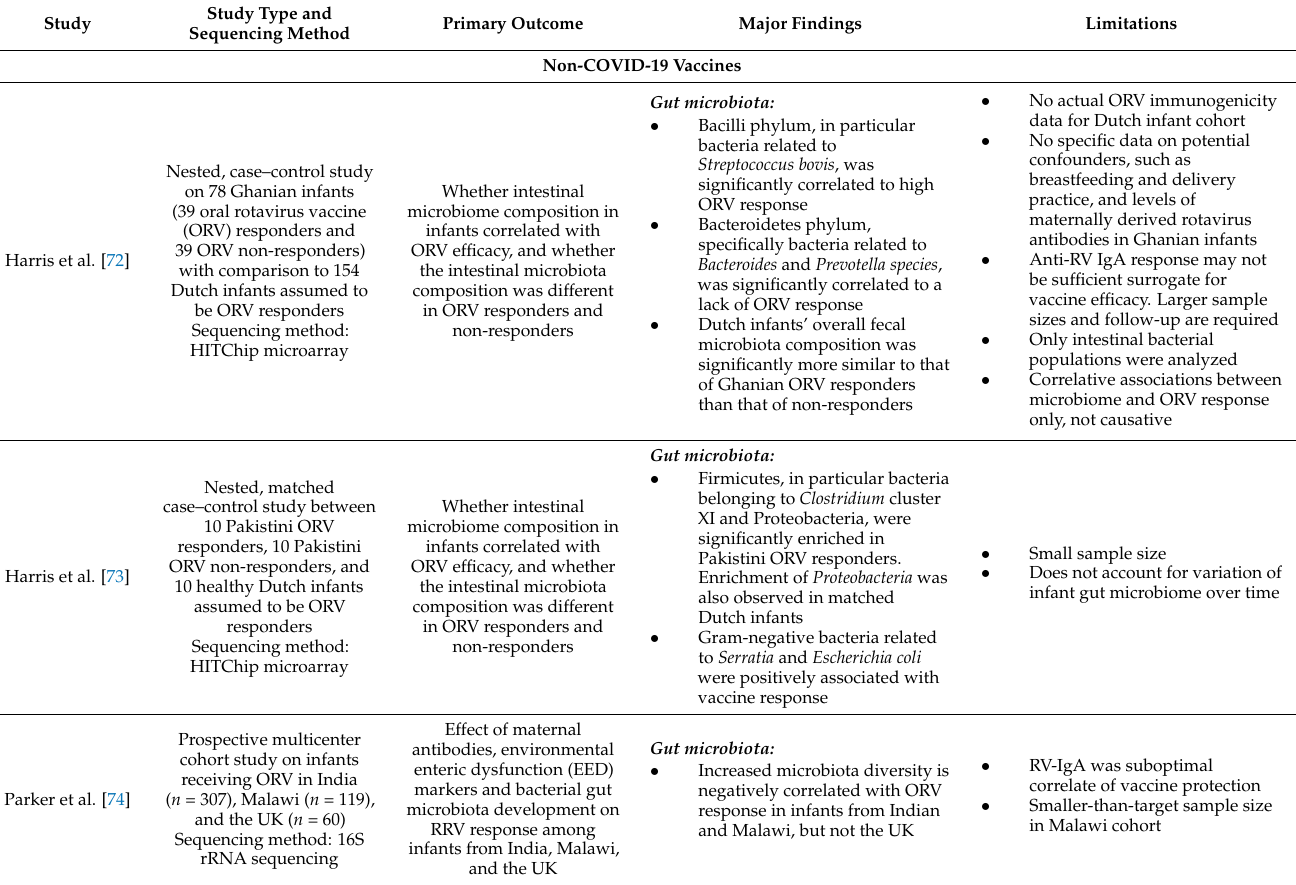
Table 2. Summary of clinical studies investigating association between gut microbiota and vaccine immunogenicity (non-COVID-19 and COVID-19